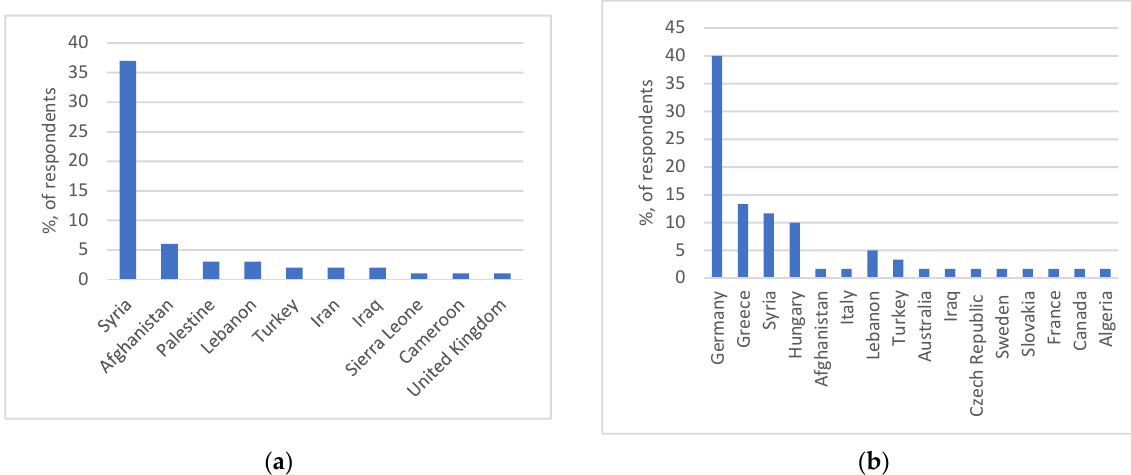
Figure 1. ( a ) Origin country of refugee researchers (RRs); ( b ) host country of RRs.